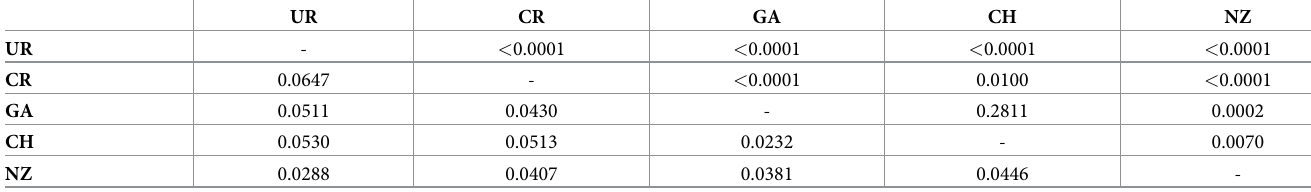
Table 3. Results of the CVA analysis with Procrustes distances (below diagonal) and their respective p-values (above diagonal) between foraging grounds. Uruguay: UR; Costa Rica: CR; Galapagos, Ecuador: GA; Chile: CH and New Zealand: